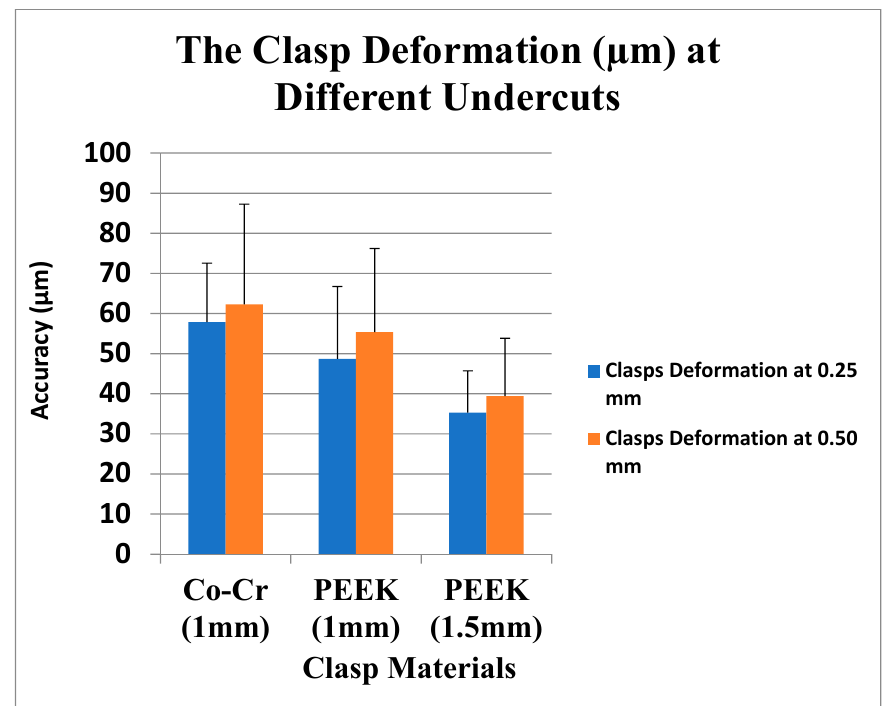
Figure 9 . The deformation of clasps inner surfaces (µm). Figure 9. The deformation of clasps inner surfaces ( µ